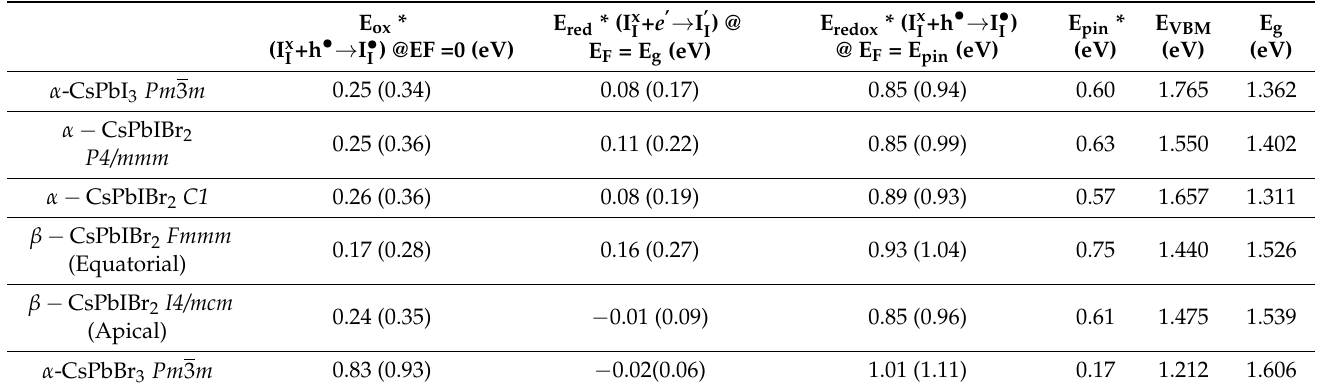
Table 3. Energies of oxidation and reduction at E F = 0 and E F = E g , respectively, as well as the energy of oxidation or reduction at the pristine Fermi pinning energy E pin *. For the former three, we included Lany–Zunger corrected values in parentheses. The valence band maximum EVBM and direct band gap energy are also included. The * distinguishes these oxidation energies from the Frenkel oxidation energies of future